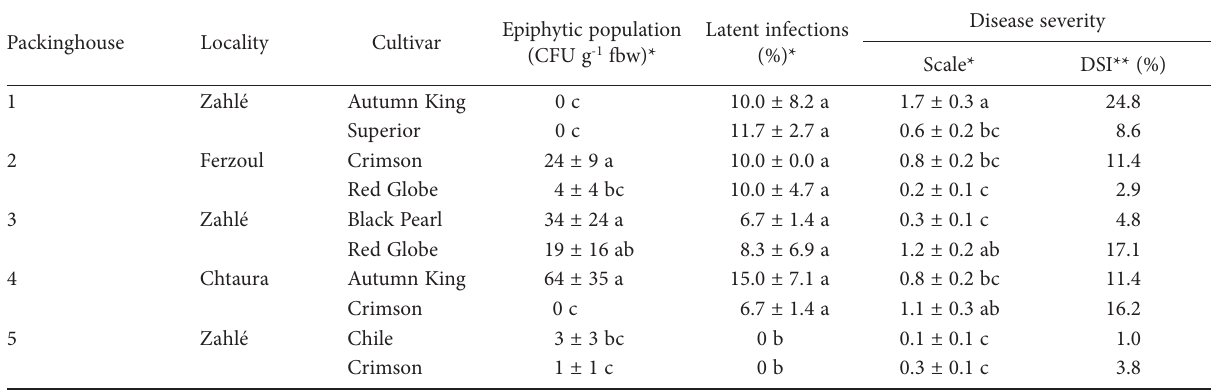
Table 3. Mean epiphytic fungal populations, latent infections and disease severities on table grapes from different packinghouses in Bekaa region (Lebanon) at the end of